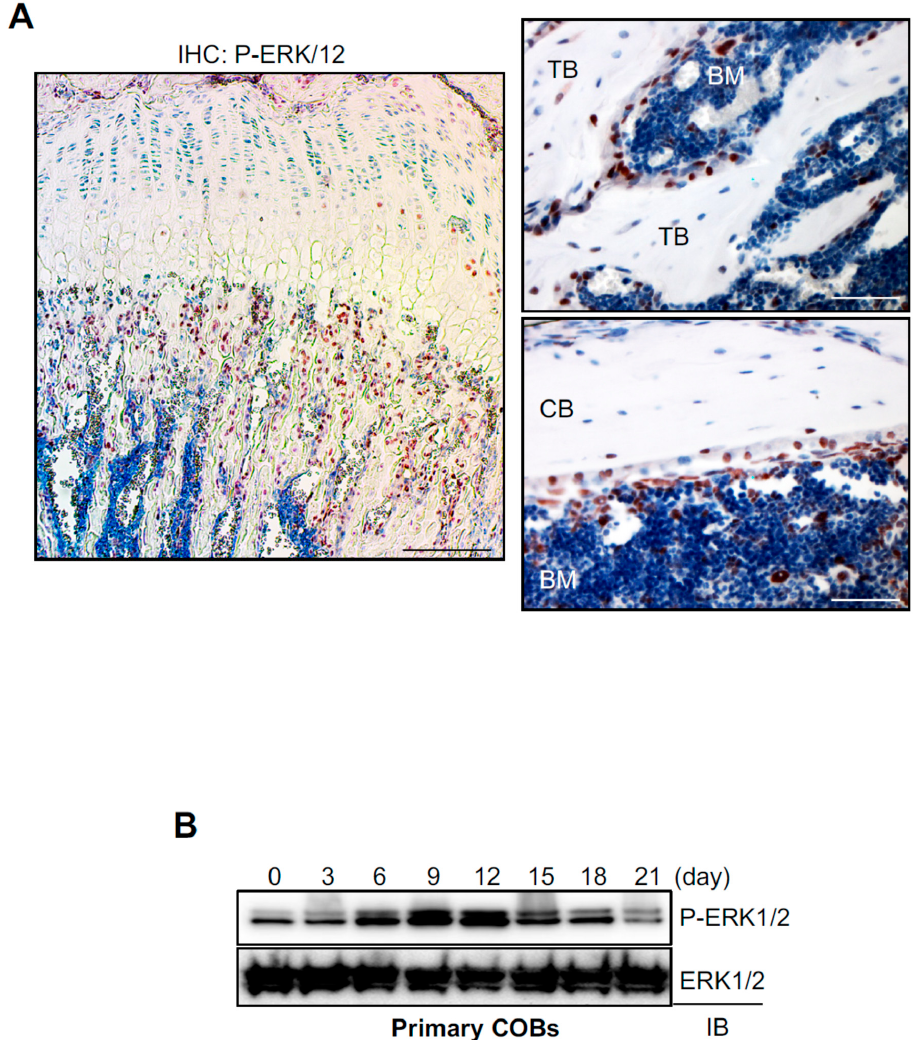
ERK1 / 2 was performed in the femur of eight-week-old male mice. TB, trabecular bone; CB, cortical Figure 1. ERK activation in osteoblasts in vitro and in vivo. ( A ) Immunohistochemistry for phospho ‐ ERK1/2 was performed in the femur of eight ‐ week ‐ old male mice. TB, trabecular bone; CB, bone; BM; bone marrow. Scale bar, 500 µ m (left) and 100 µ m (right). ( B ) Primary calvarial osteoblasts (COBs) were isolated from mouse calvaria at Postnatal Day 5 and cultured under osteogenic conditions. Phosphorylation of ERK1 / 2 was determined by immunoblotting with anti-P-ERK1 / 2 antibody. ERK1 / 2 was used as a loading